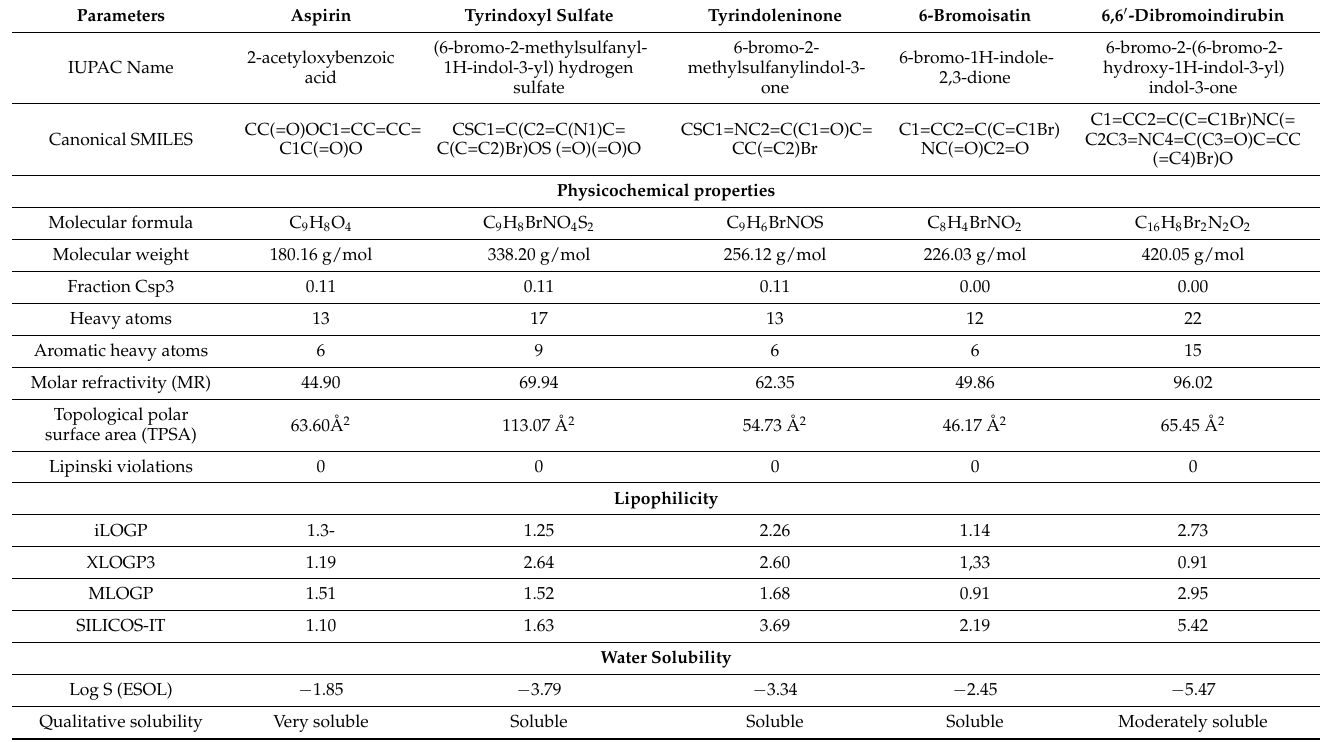
Table 3. Physicochemical properties and drug-likeness parameters of secondary metabolites of the Dicathais orbita compound in comparison with a standard